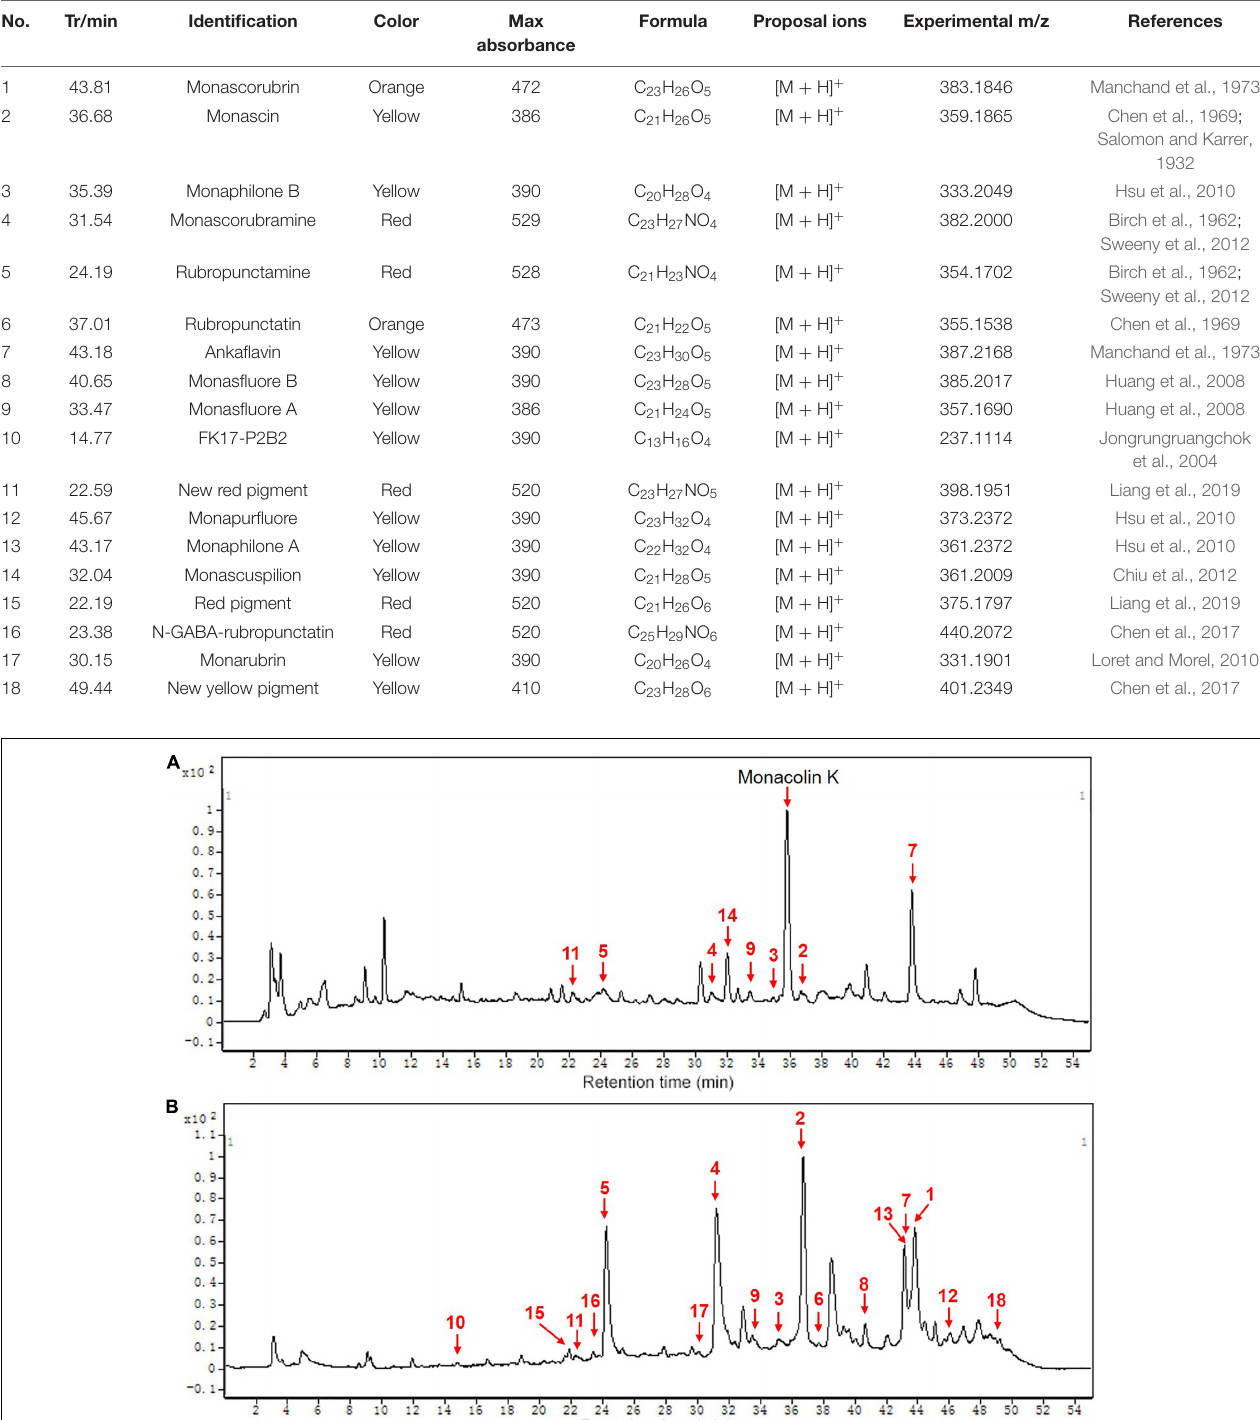
TABLE 4 | Monascus pigments composition.